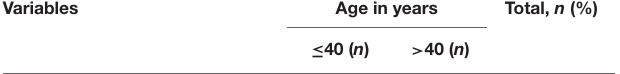
TABLE 2 | Clinical characteristics by age of respondents. TABLE 3 | Source of information, degree of damage and support for